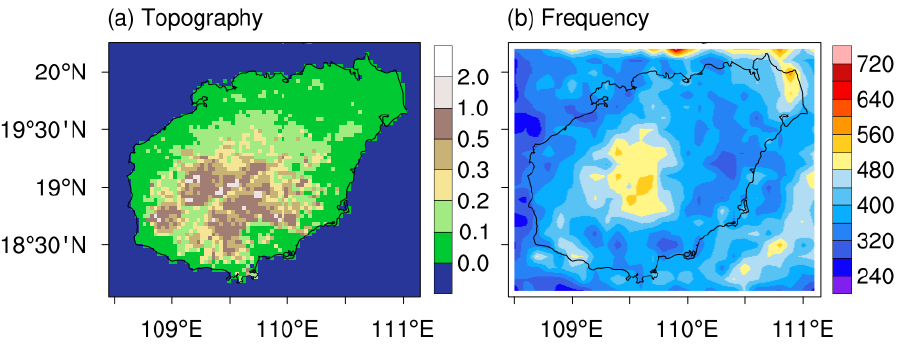
Figure 1. ( a ) Topography of Hainan Island region (units: km), ( b ) frequency of rain clusters (bin: 0.1°).